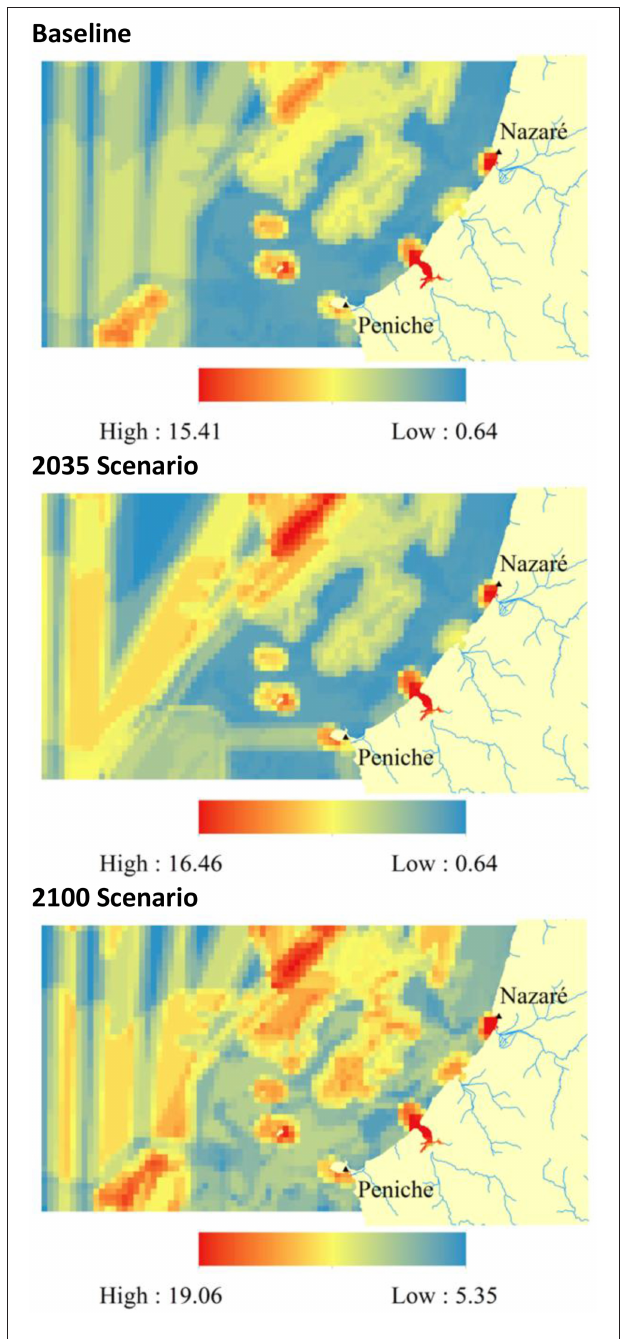
FIGURE 4 | Cumulative risk map for the complex Atlantic region between Peniche and Nazaré, with a resolution of 1x1km, for the present condition (baseline) and for the years 2035 and 2100 prospective